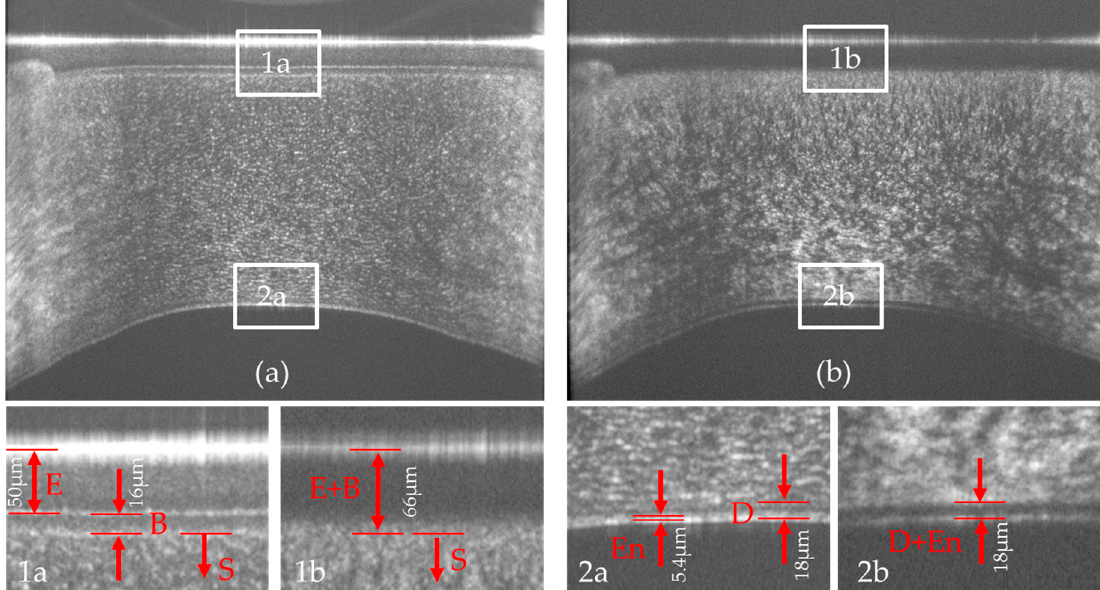
Figure 3. Averaged B-scan (60 times) of the cornea recorded with the instrument in the co- and cross- polarized detection channel. ( a ) Co-polarized detection channel; ( b ) Cross polarized detection channel. The lower row shows magnified views (3 × ) of the regions of interest that are marked with white rectangles in the upper row. ( 1a ) and ( 1b ) enlarged view of the anterior part of the cornea, ( 2a ) and ( 2b ) enlarged view of the posterior part of the cornea of the co- and cross-polarized channel. The field of view of the large images is 11 mm (x) and 867 µm (z). E (epithelium), B (Bowman’s layer), S (stroma), D (Descemet’s membrane), En (endothelium).